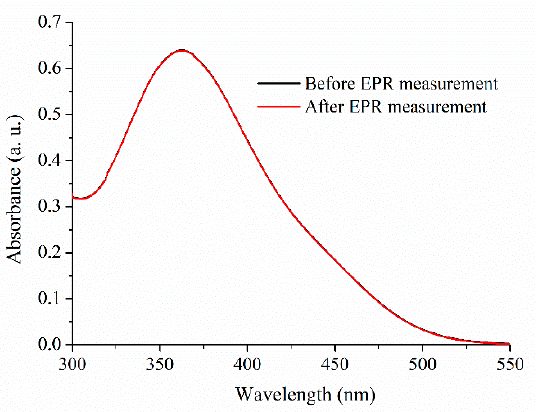
Figure 3. UV-vis absorption spectra of trans -PHX samples before and after EPR measurement.